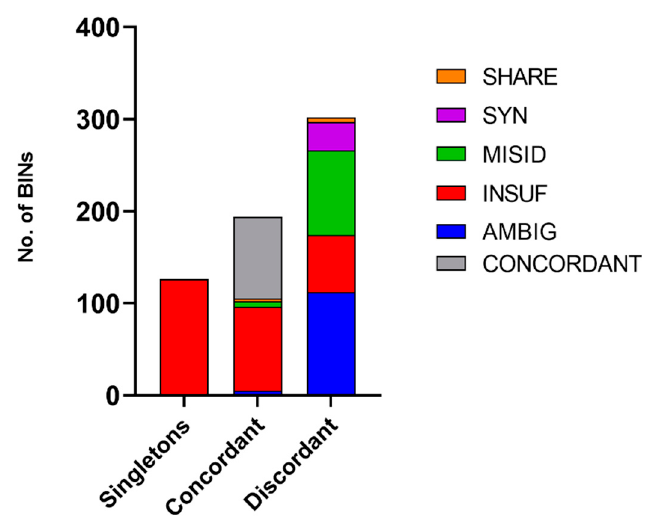
Figure 4. Results from the BIN discordance report performed on the BOLD database. This analysis separates the BINs into three categories: singletons (BINs with only one record), concordant (BINs with no taxonomic discordance), and discordant (BINs with taxonomic discordance). The BINs were then tagged according to the designed workflow into: AMBIG (ambiguous records), INSUF (insuf- ficient records), MISID (misidentifications), SYN (synonyms), or SHARE (if the BIN system was not able to discriminate well-established species).